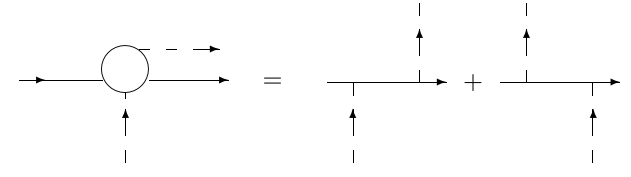
FIG. 2. Compton scattering of equivalent photon on the electron.